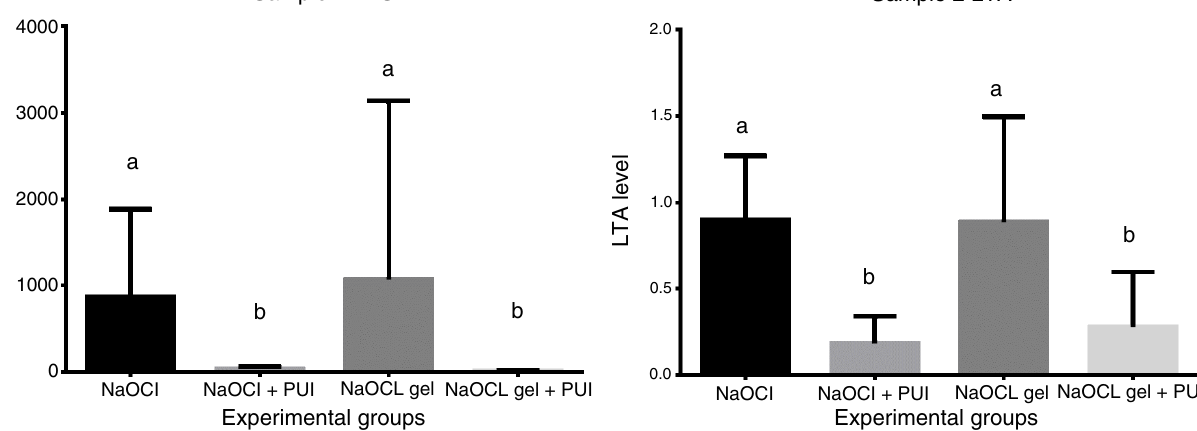
Figure 3. Statistical difference among the experimental groups at S2 for LPS and LTA levels. NaOCL, sodium hypochlorite; PUI, passive ultrasonic irrigation; LPS, lipopolysaccharide; LTA, lipoteichoic acid.